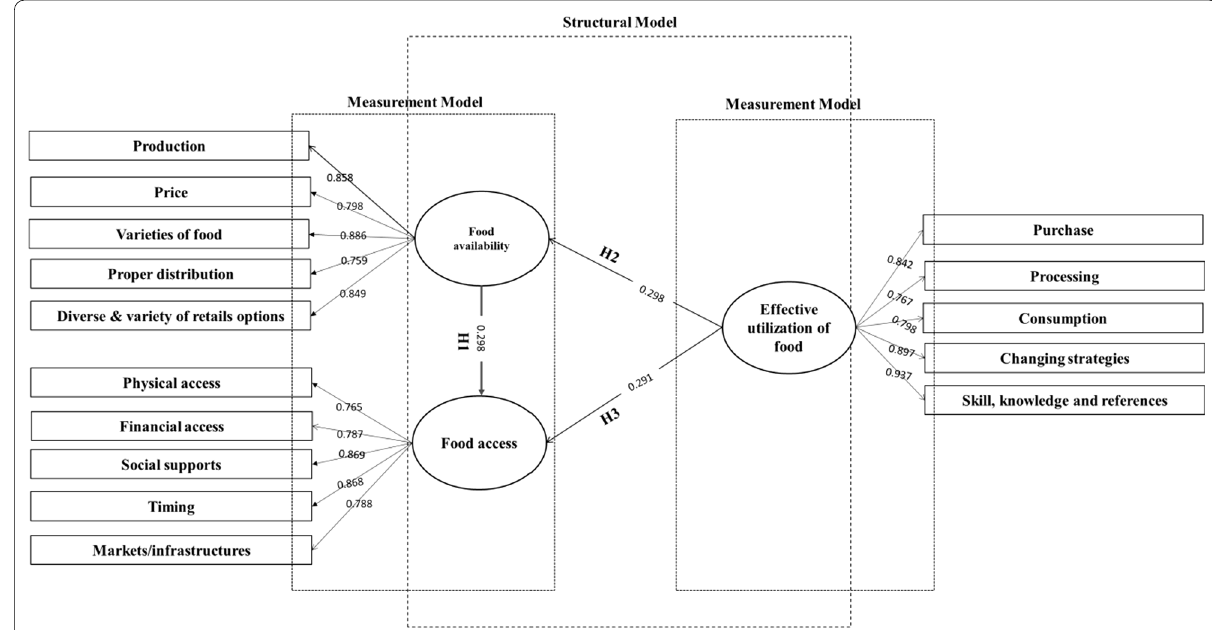
Fig. 2 Complete SEM frameworks for the determinants of